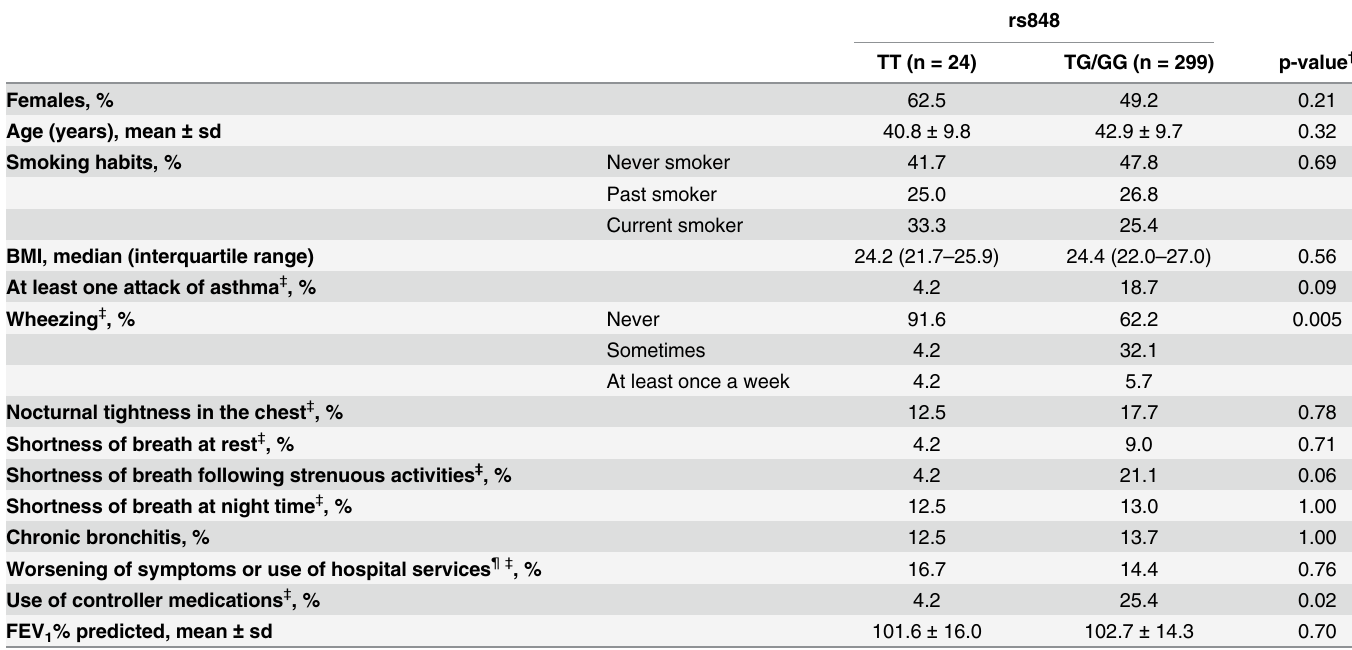
Table 3. Main characteristics of the asthmatic subjects, according to their genotype * in SNP rs848 in the IL13 gene